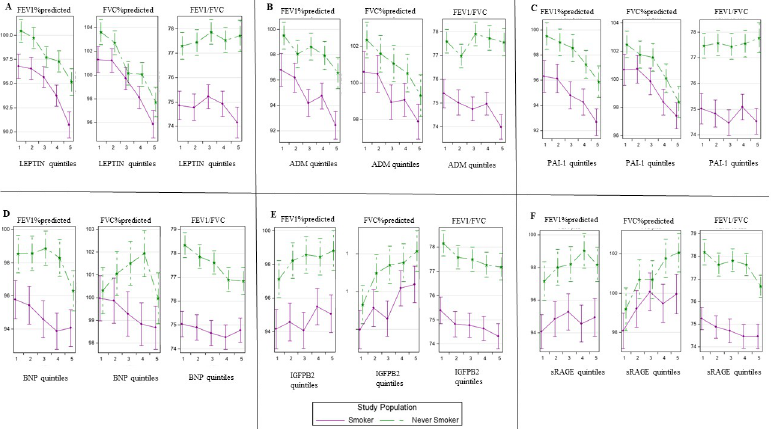
Fig 2. Association of selected proteins (quintiles) with lung function stratified by smoking status. Adjusted least square means of spirometry traits across quintiles of the four protein biomarkers with the greatest inverse effect on FEV 1predicted% and two protein biomarkers with positive association on FEV 1%predicted and FVC %predicted (A. Leptin; B. ADM; C. PAI-1; D. BNP; E. IGFBP2; F. sRAGE).